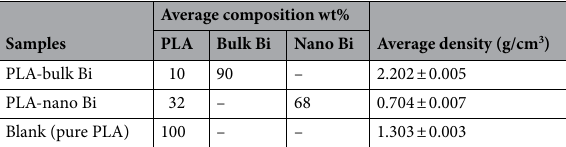
Table 1. The compositions and densities of the produced samples.